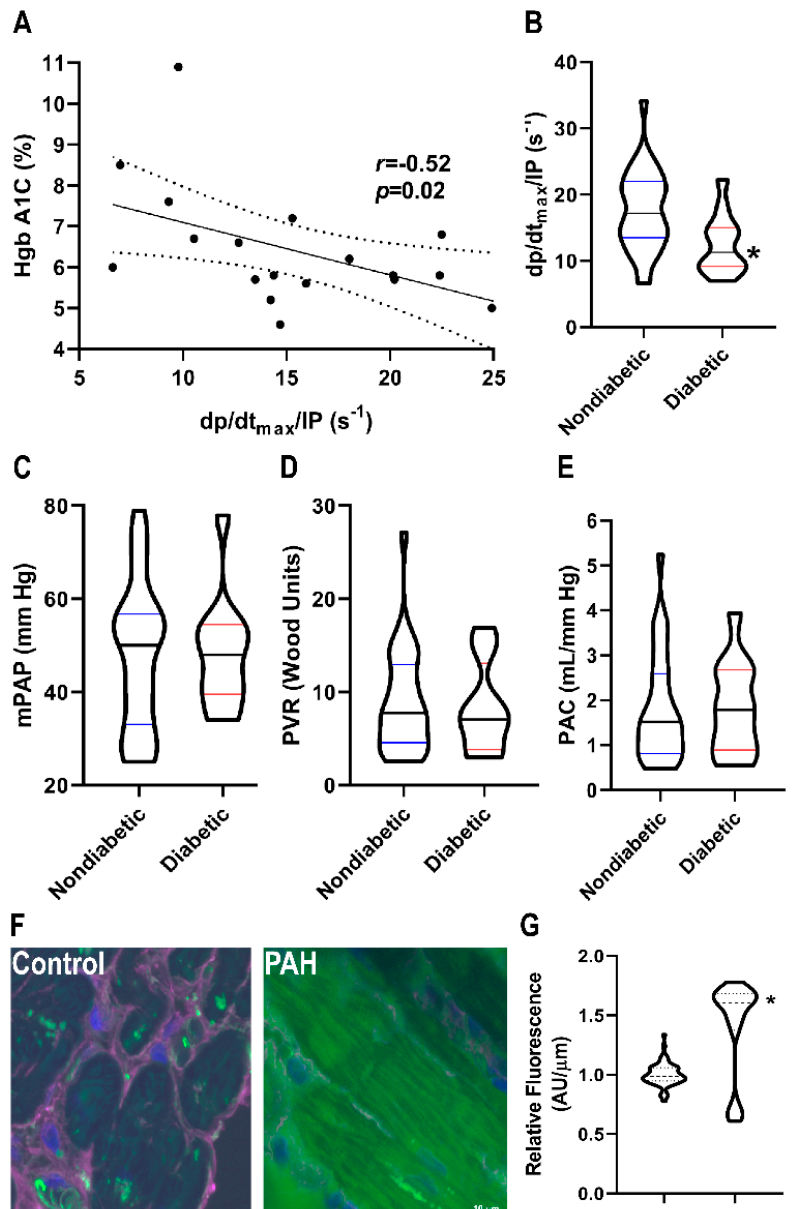
Figure 5. Relationship between O-GlcNAcylation and RVD in PAH patients. ( A ) Correlation between HgbA1C and right ventricular contractility in PAH patients. There is a significant negative relationship between HgbA1C and right ventricular contractility ( r = − 0.52, p = 0.02) ( B ) Diabetic patients have lower right ventricular contractility than nondiabetic PAH patients (12.5 ± 4.5 s − 1 vs. 17.5 ± 6.0 s − 1 , p = 0.01). There were no significant differences in pulmonary vascular disease severity in diabetic versus nondiabetic patients as quantified by mean pulmonary artery pressure (48 ± 12 vs. 48 ± 16 mmHg, p = 0.37) ( C ), pulmonary vascular resistance (8.3 ± 4.9 vs. 8.9 ± 5.5 Wood units, p = 0.68) ( D ), and pulmonary arterial compliance (1.8 ± 1.0 vs. 1.8 ± 1.2 mL/mm Hg, p = 0.64) ( E ). ( F ) Representative confocal micrographs of right ventricular sections stained with succinylated wheat germ agglutinin (WGA). ( G ) Quantification of succinylated WGA signal intensity in right ventricular cardiomyocytes from two control ( n = 63 total cells analyzed) and two PAH biopsy specimens ( n = 55 total cells analyzed). Green: Succinylated WGA, Blue: DAPI, and Magenta: WGA. * indicates significantly different as determined by t -test in ( B ) or Mann–Whitney U-test in ( G ).